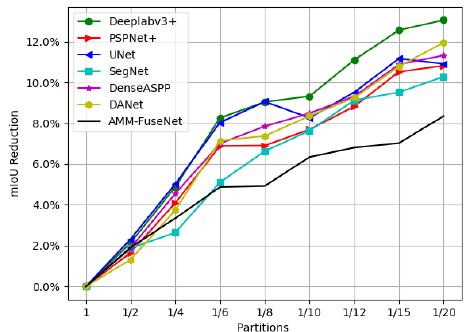
Figure 11. Percentage decrease on mIoU for different partitions of the Potsdam dataset for each